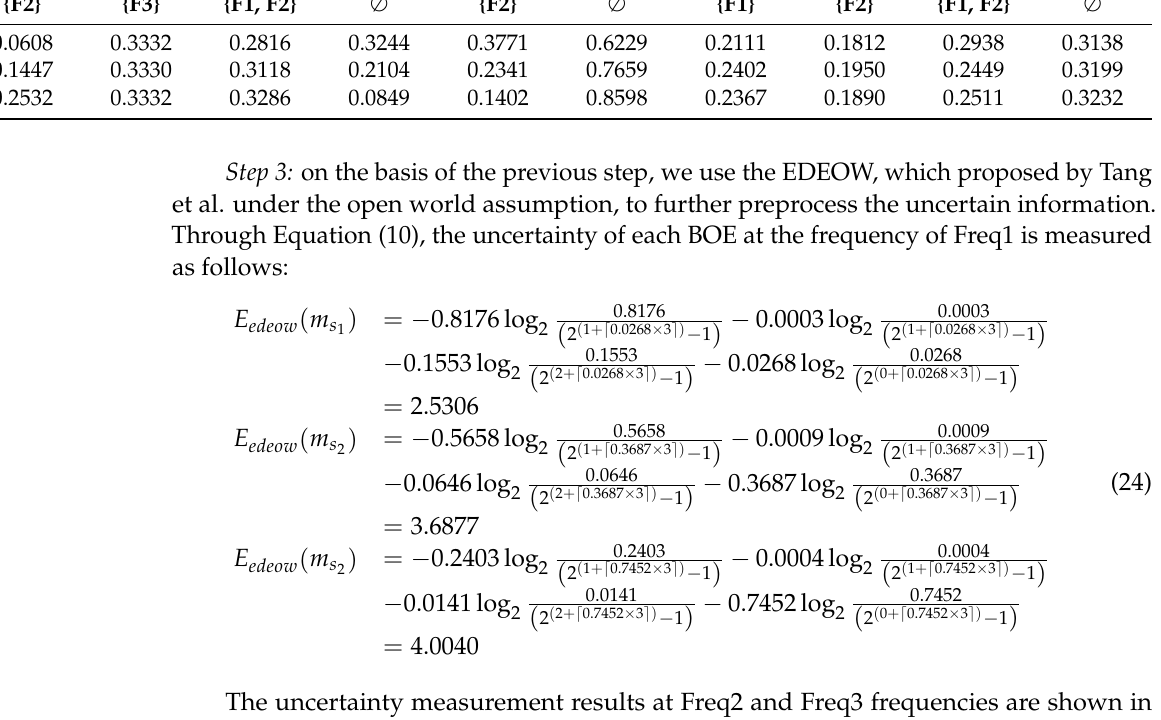
Table 6. Table 6. Uncertainty measurement results of BPAs based on